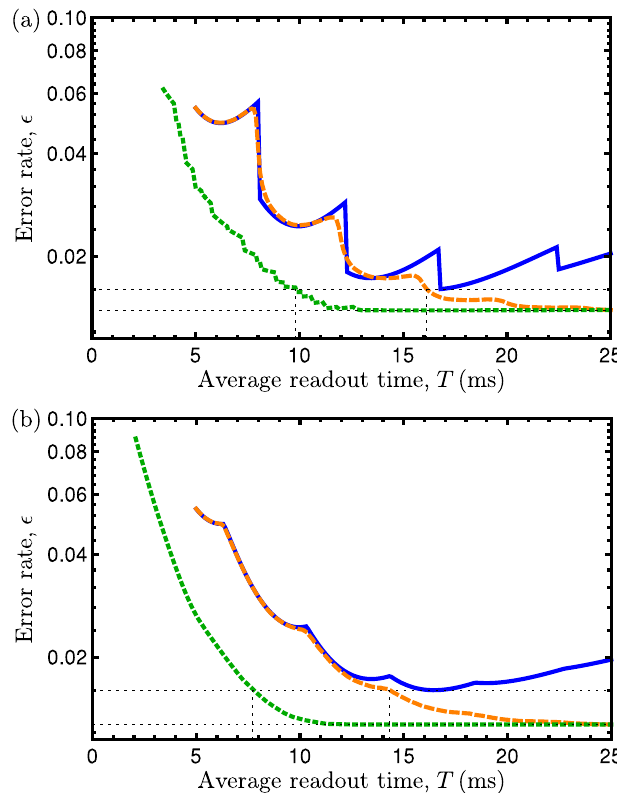
FIG. 6. Monte Carlo simulated error rate for an unbalanced initial charge distribution with P ðþÞ ¼ 0 . 25 when (a) the value of P ðþÞ is unknown (MLE) and (b) the value of P ðþÞ is known (MAP). In both cases, we show the error rate for the photon- counting method of Ref. [12] (solid blue), the nonadaptive readout (dashed orange), and the adaptive readout (dotted green). The horizontal dotted black lines indicate the minimum error rates of the photon-counting method (1.6% in both cases) and of the optimal methods (1.4% for the MLE and 1.3% for the MAP). The dotted vertical lines show that significant adaptive-decision =T ≈ 1 . 6 and t =T ≈ 1 . 8 are obtained when using speedups of t f f the MLE and MAP, respectively. The discontinuous features in (a) occur because the MLE uses a nonoptimal discrimination threshold when P ð(cid:3)Þ ≠ 0 . 5